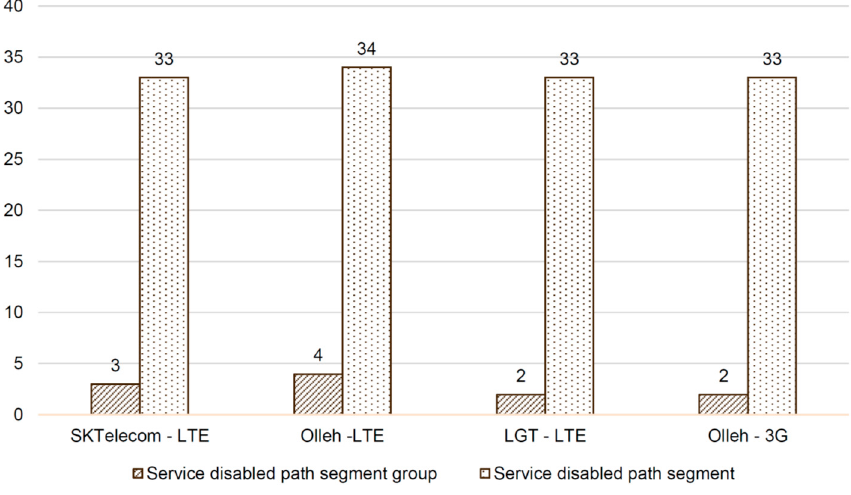
Figure 11. Service disabled path segment and group size evaluation result.